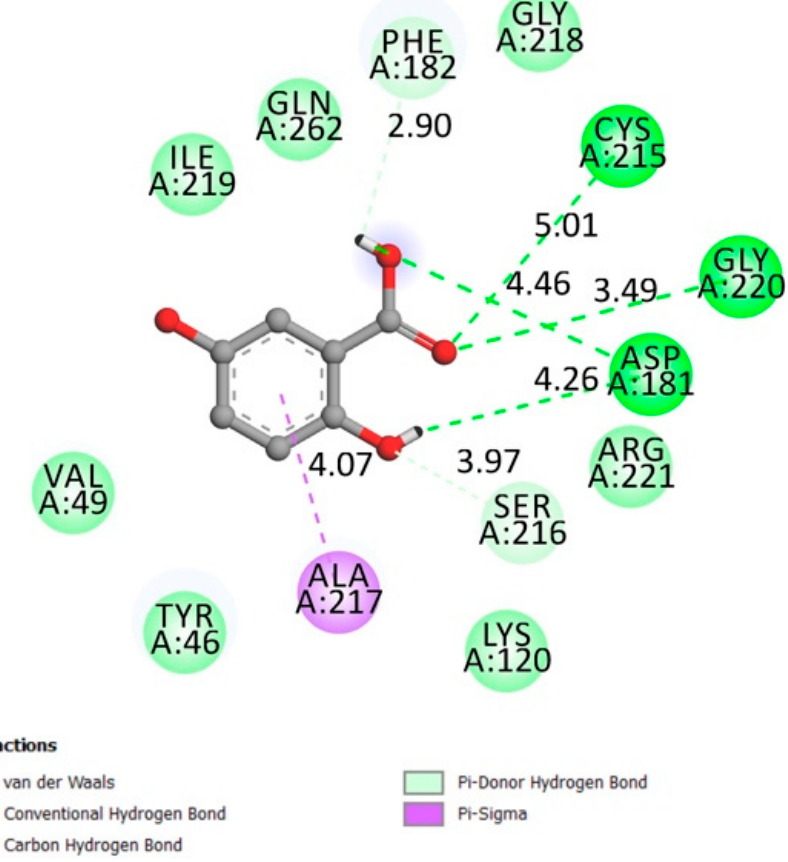
Figure 1. Two-dimensional (2D) scheme of the gentisic acid (GA) interactions with protein tyrosine phosphatase 1B (PTP1B) receptor.